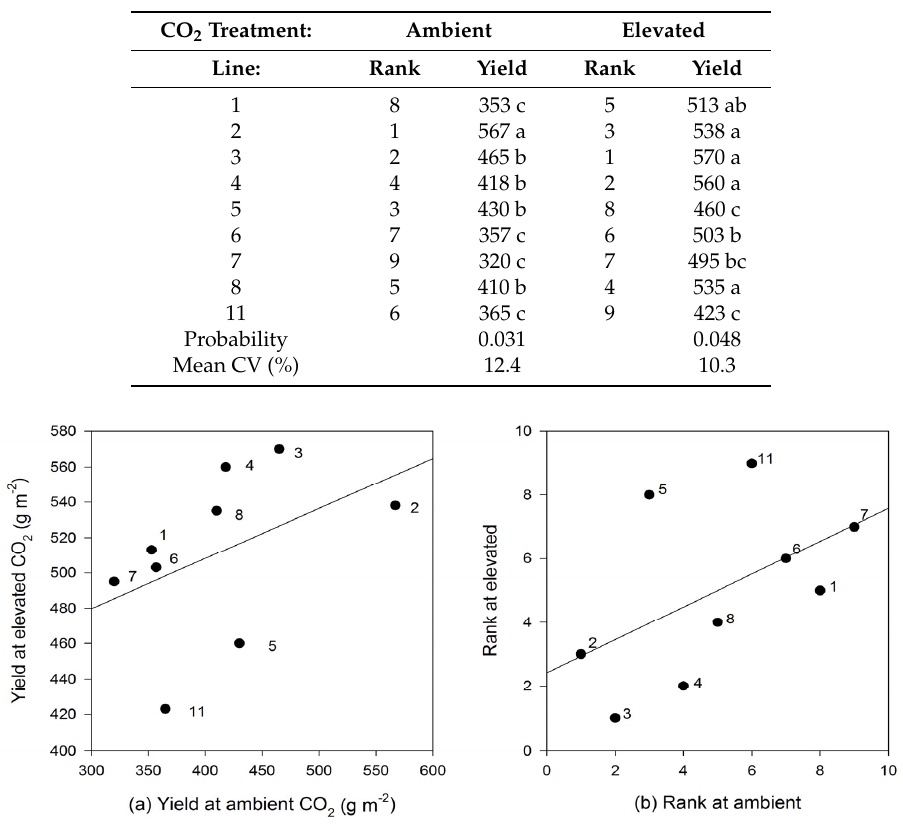
Table 2. The mean seed yield (g dry mass m − 2 ) and the ranking of mean yield of nine wheat lines grown at elevated and ambient CO 2 in 2015; the probability of significant differences in yield within a year and CO 2 treatment; and the mean coefficient of variation (CV). Within columns, values followed by different letters were significantly different at p = 0.05, by ANOVA. The identity of the nine lines is presented in Table 3.